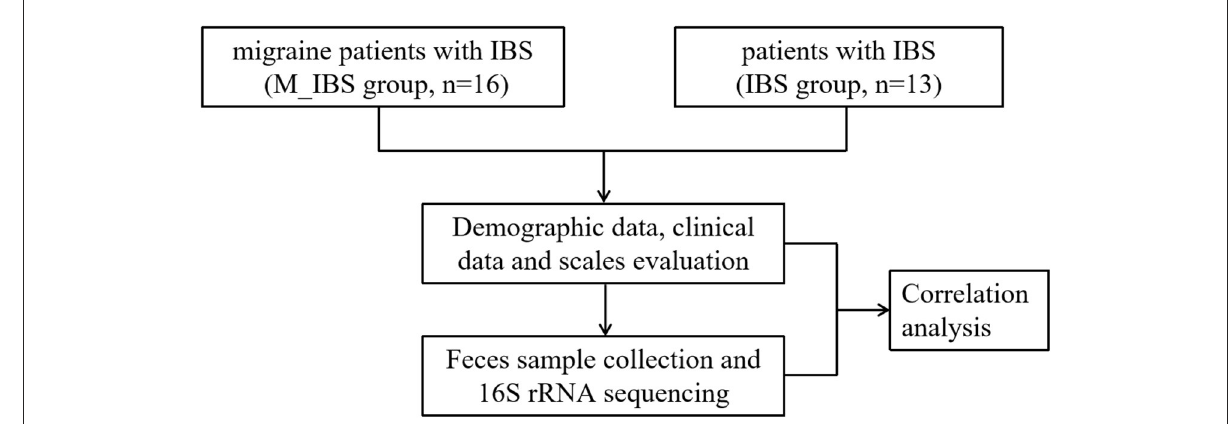
FIGURE1 Flowchart illustrating the recruitment of migraine patients with IBS and patients with IBS and the research implementation